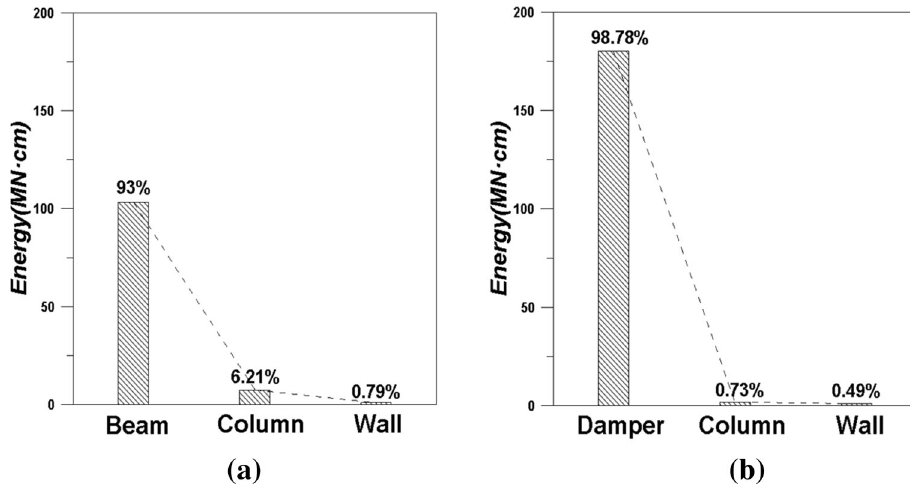
Fig. 21 Hysteretic energy dissipated by each structural element. a CD_IC and b